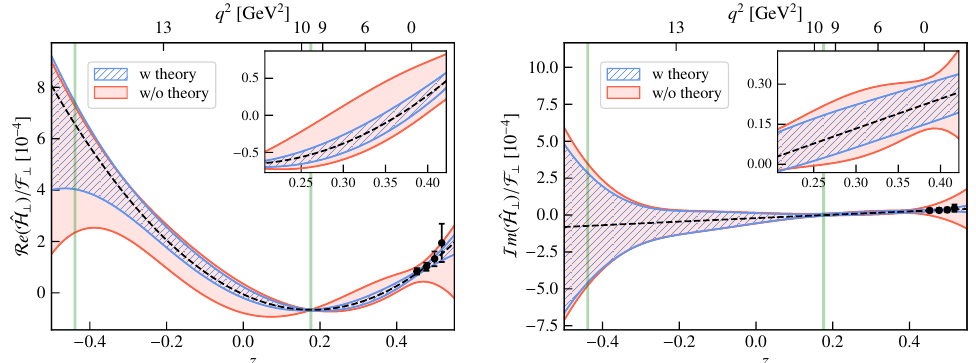
Figure 2 . Results of the (cid:12)ts for the ratios ^ H ? ( z ) = F ? ( z ) obtained with and without the theoretical points calculated at negative q 2 . Fits correspond to the BMP scenario, the expected statistics at LHCb Upgrade [50 fb (cid:0) 1 ] and to z 4 truncation in the series expansion. The vertical bands correspond to the J= and (2 S ) regions; the points to the theoretical inputs at negative q 2 . The top right box of each plot zooms in the q 2 range between 1.1 and 9.0 GeV 2